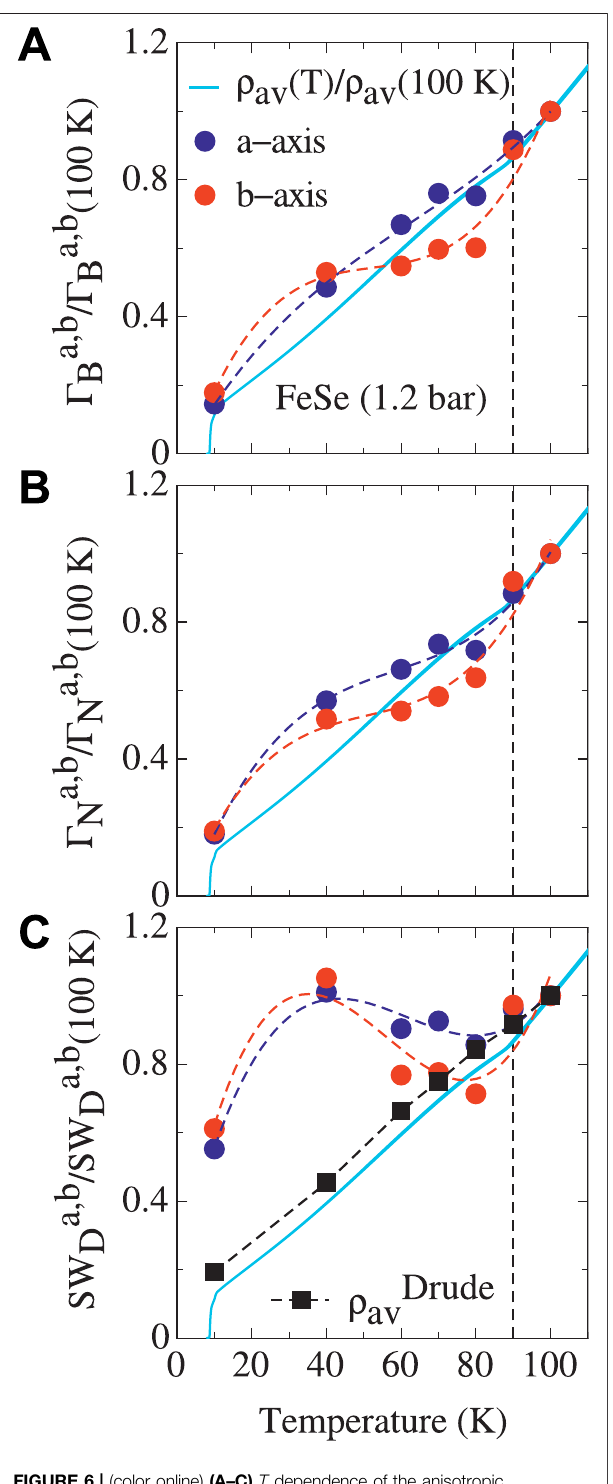
FIGURE 6 | (color online) (A – C) T dependence of the anisotropic scattering rates ( Γ a , b N , B ) for the narrow (N) and broad (B) Drude term as well as of the total Drude spectral weight SW a , b D (see text), at p = 1.2 bar (i.e., for fully detwinned samples) along both orthorhombic a - and b -axis. The measured, average dc resistivity between the two axes is replicated from Ref.